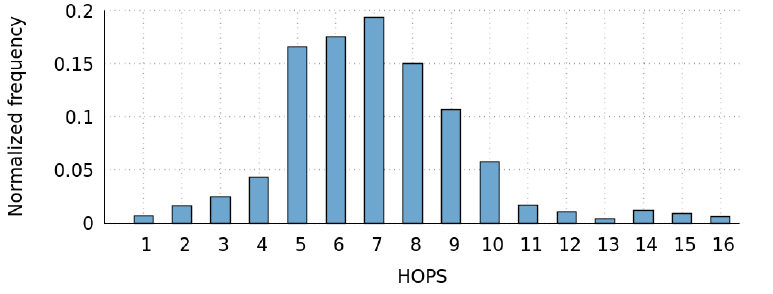
Figure 1. Frequency of the OLSR path